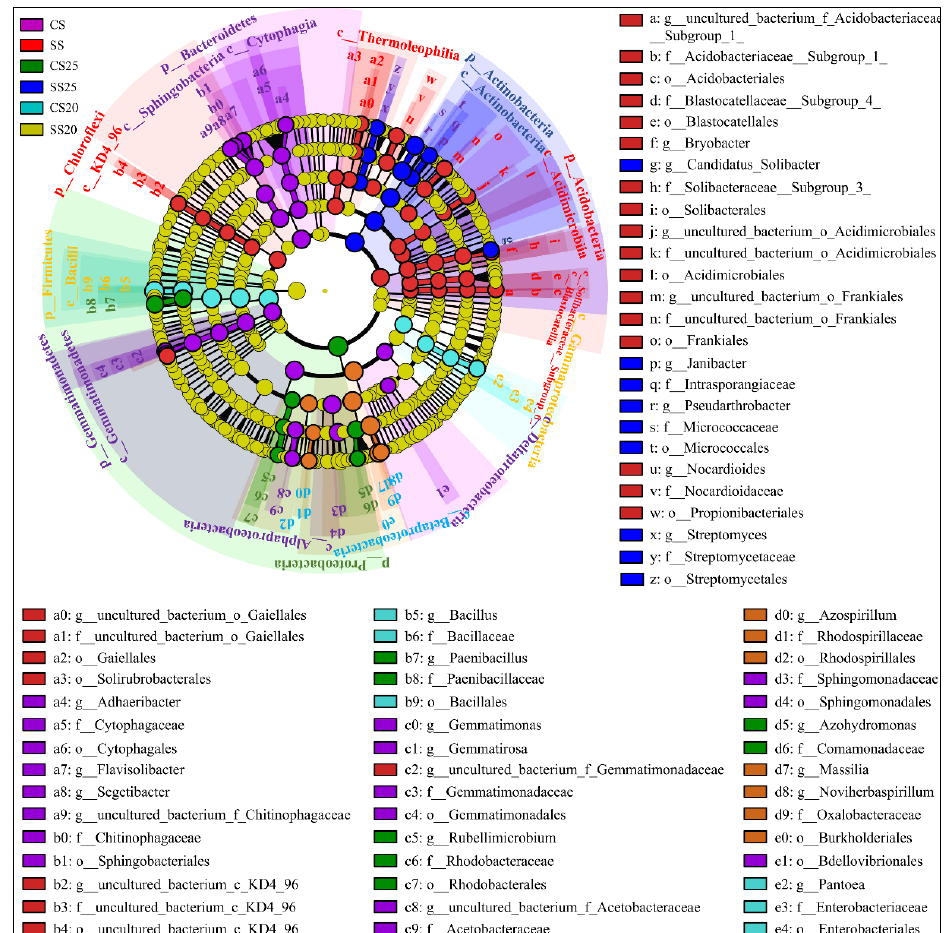
Figure 5. Cladogram showing specific phylotypes of bacterial community compositions of peanut spermosphere responding to salt stress. Circles indicate phylogenetic levels from phylum to genus (from the outer circle to the inner circle). The diameter of each circle is proportional to the abundance of the bacterial